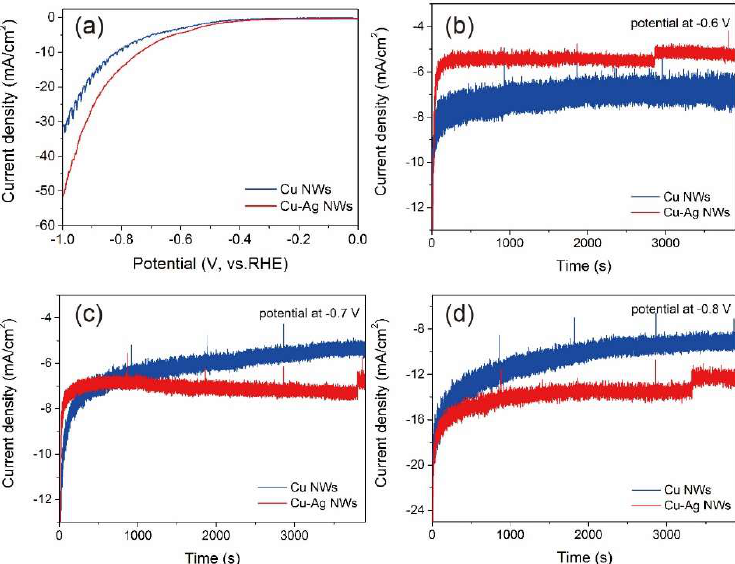
Cu-Ag NWs with 5 mV/s scan rate. CO 2 reduction activity on the Cu NWs and the Cu–Ag NWs at different potentials: ( b ) − 0.6 V, ( c ) − 0.7 V, and ( d ) − 0.8